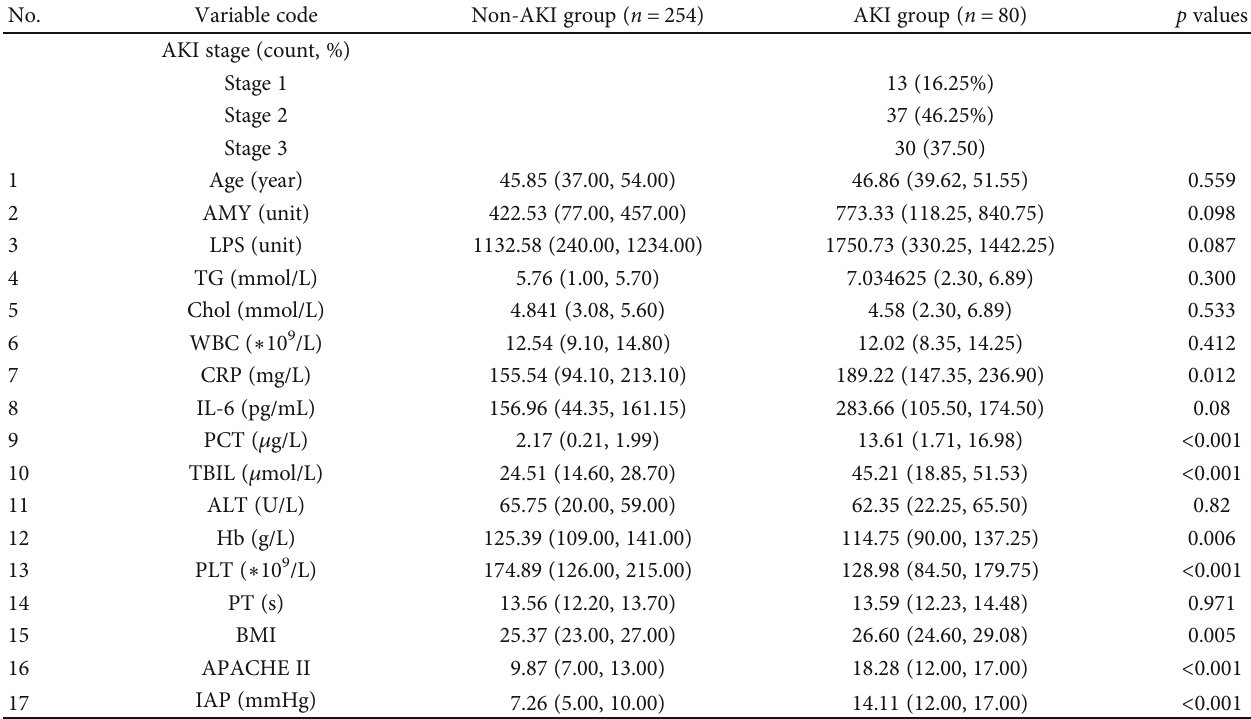
Table 1: The continuous variable characteristics of AP